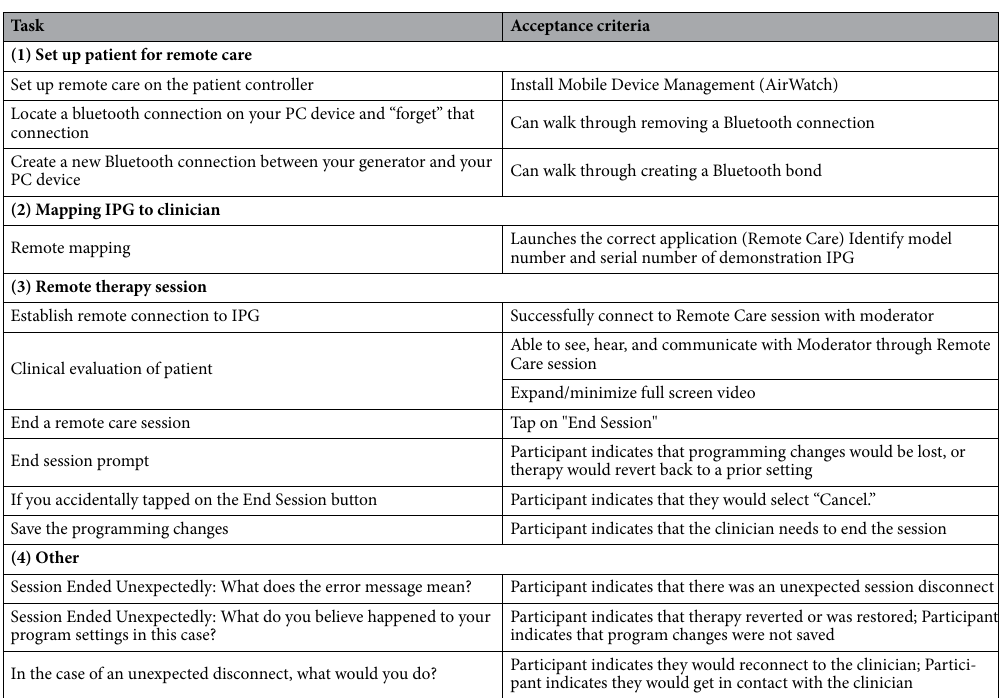
Table 4. Task description and use scenarios for usability testing with